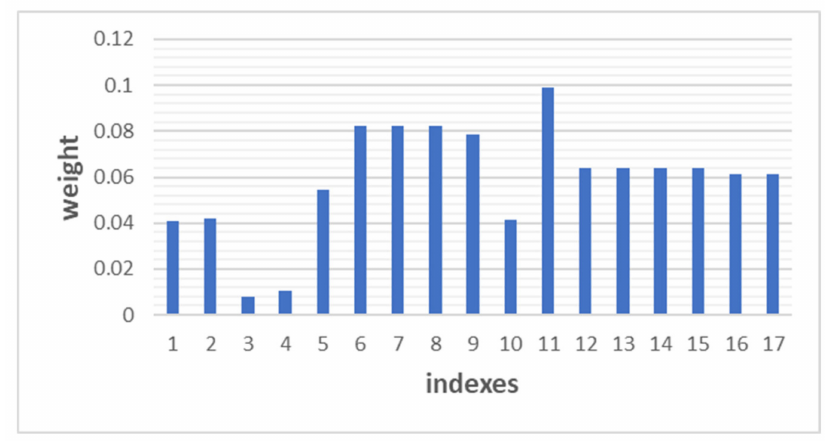
Figure 4. Weight-characteristic quantity correspondents.